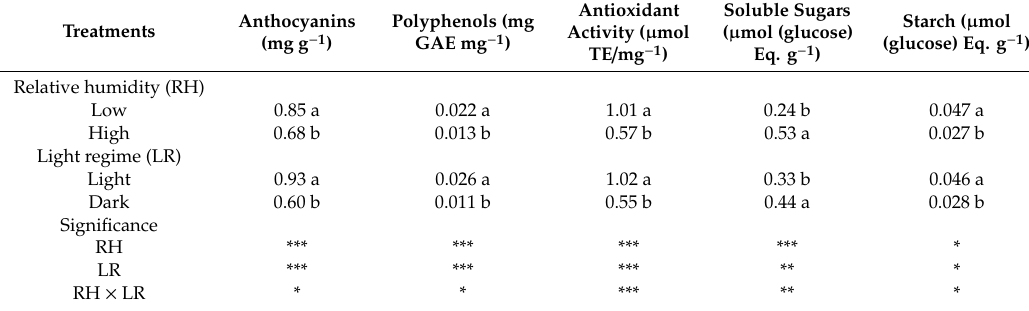
Table 3. Analysis of variance and means comparison for functional metabolites and antioxidant activity of mung bean sprouts the four di ff erent combinations of RH and LR (LowRH-L; LowRH-D; HighRH-L; HighRH-D). Data are expressed on a fresh weight basis. Mean values and statistical significance are shown. NS, *; **, *** Non significant or significant at p ≤ 0.05, 0.01, and 0.001, respectively. Di ff erent letters within each column indicate significant di ff erences according to Duncan’s multiple-range test ( p ≤ 0.05).